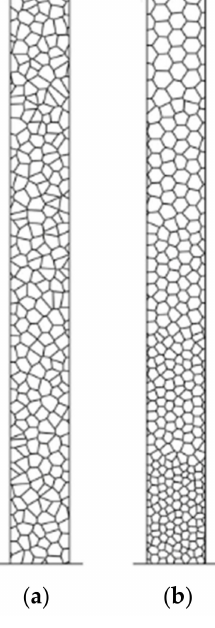
Figure 19. Irregular Voronoi-like grid pattern for tall buildings: ( a ) uniform density; ( b ) gradually rarefying density. Used with permission from Angelucci and Mollaioli